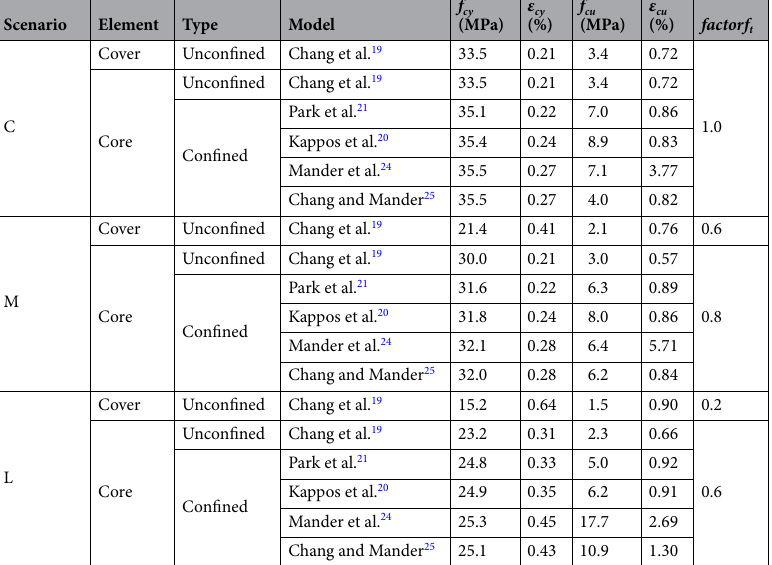
Table 4. Key properties of concrete for the three